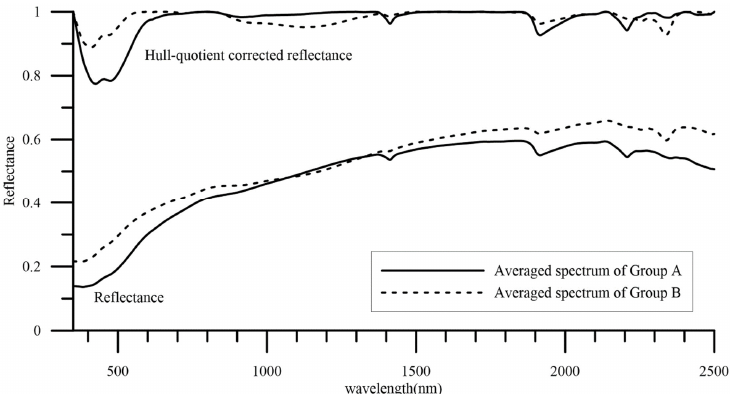
Figure 4. The averaged reflectance and averaged hull quotient corrected spectra of Group A and Group B.